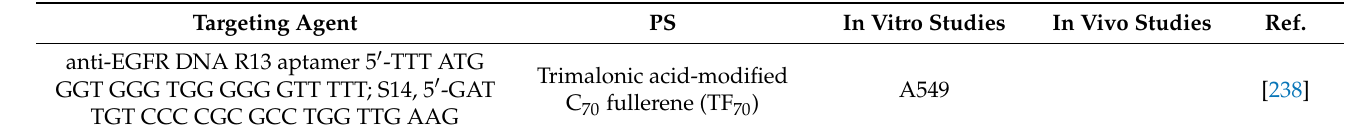
Table 14. EGFR-targeted PDT performed with an anti-EGFR aptamer. Targeting Agent PS In Vitro Studies In Vivo Studies Ref.